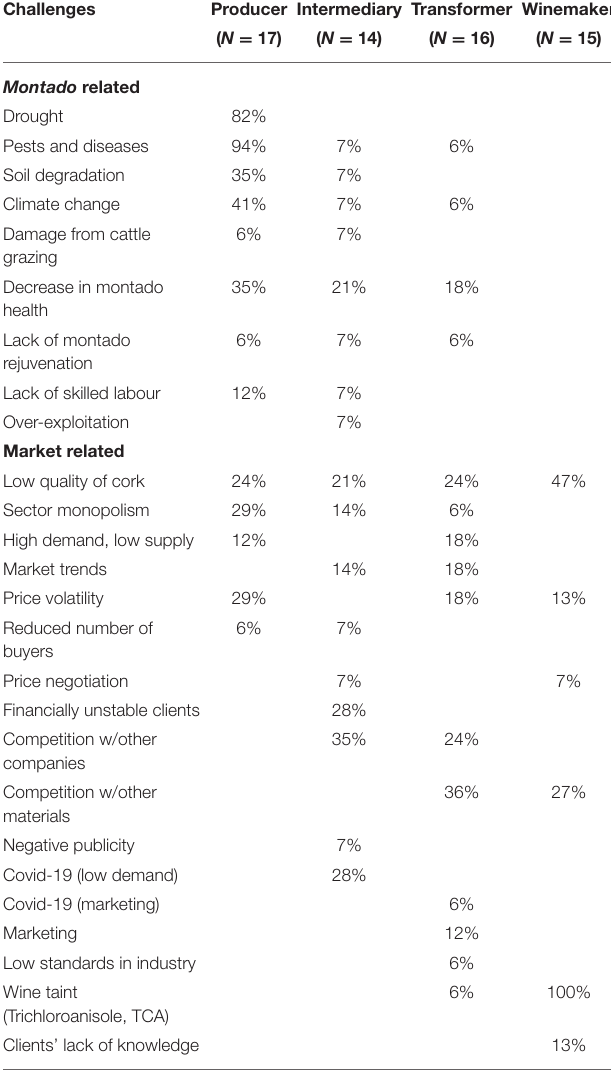
TABLE 2 | Overview of challenges mentioned by our